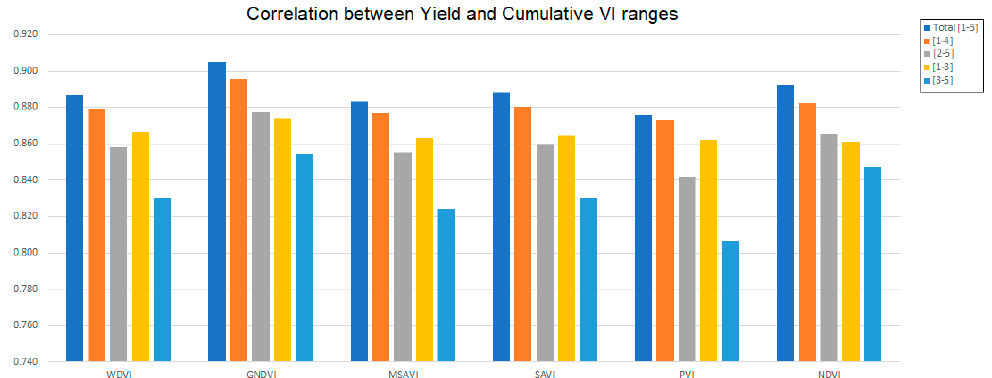
Figure 7. The correlation between different cumulative ranges and recorded yield, for all implemented VIs. Table 18. The regression models that best describe yield (expressed in t/ha) through VI data for the maximum cumulative range [1–5], along with their adjusted R-Squared and MAE values (All VIs presented significant correlations at the p < 0.05 level).